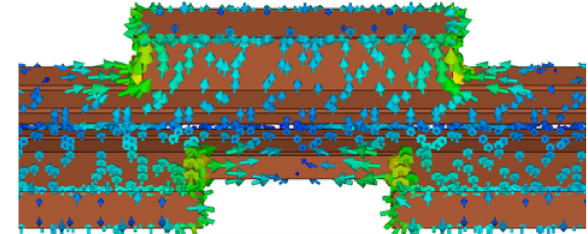
quadrant.FIG. 14. The surface current of a window-type RFQ in one